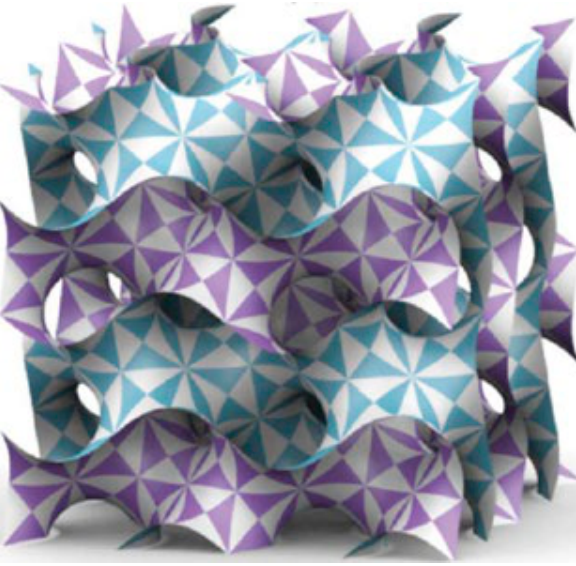
Figure 1. Bicontinuous cubic phases of phospholipids. The average or sum of normal curvatures is everywhere zero, the Gaussian curvatures varies continuously. Reproduced from Ref. 12 with permission of the International Union of Crystallography. http://journals.iucr.org/